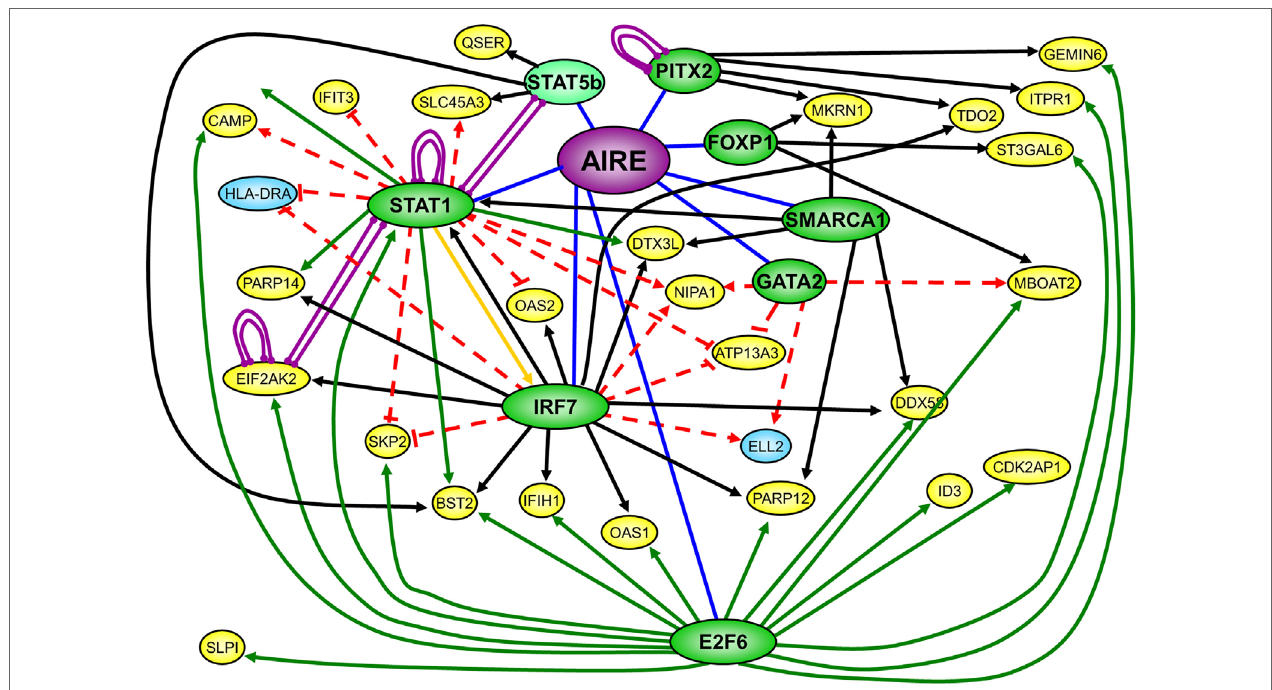
FigUre 4 | Summary of EdgeExpress DB output diagram of conserved list of autoimmune regulator (AIRE)/Aire-regulated genes showing key nodes with multiple edges and a selection of interacting nodes. Green nodes correspond to nodes reported with many edges, with dark green corresponding to AIRE/Aire upregulated genes, and light green to downregulated genes. Yellow and blue nodes correspond to the interacting nodes of AIRE/Aire upregulated and downregulated genes, respectively, with each node having three edges or less. Purple edges denote protein–protein interactions, black edges denote transcription factor-binding sites edges, green edges denote ChIP interaction edges, and red edges denote siRNA/miRNA perturbation